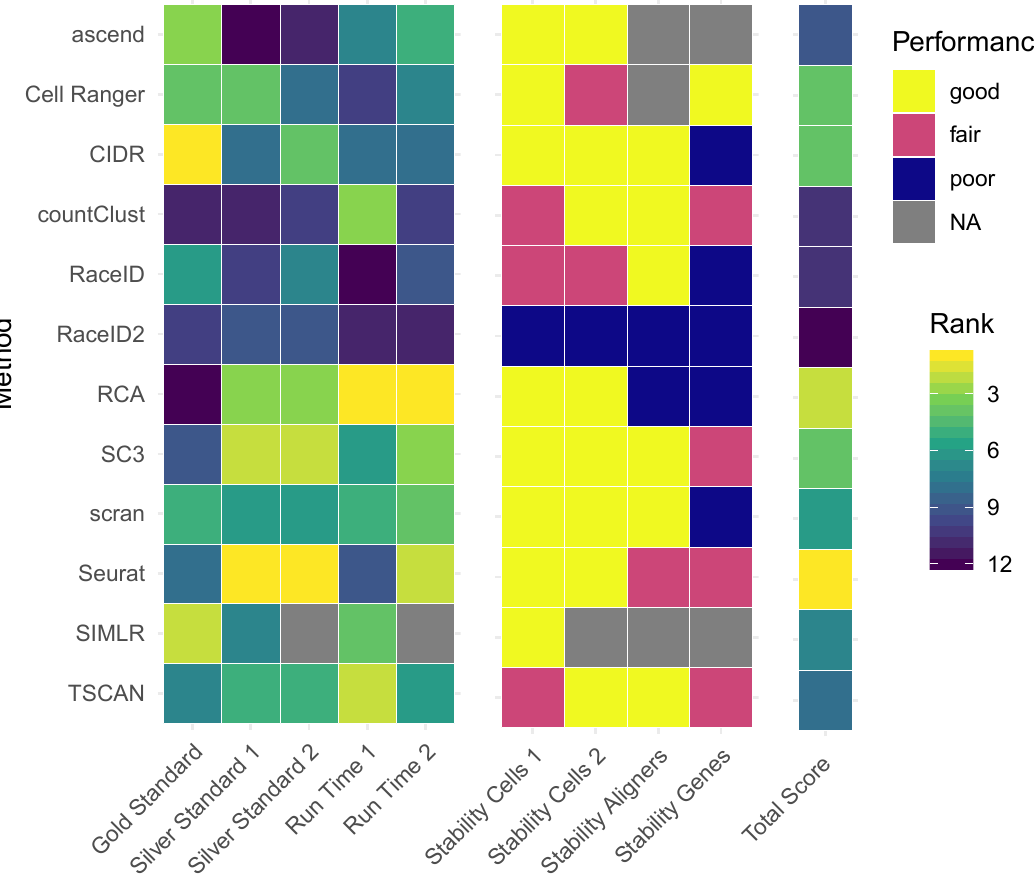
Figure 9. Summary of the performance of each method across all evaluations. Note that 1 refers to evaluation 1 (R version 3.4.3) and 2 refers to evaluation 2 (R version